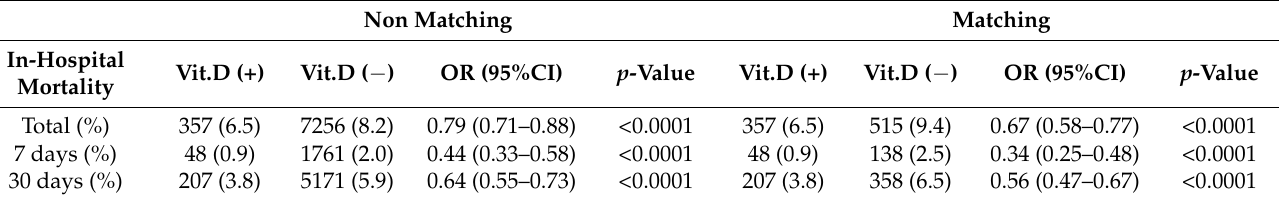
Table 2. In-hospital mortality before and after propensity score matching.